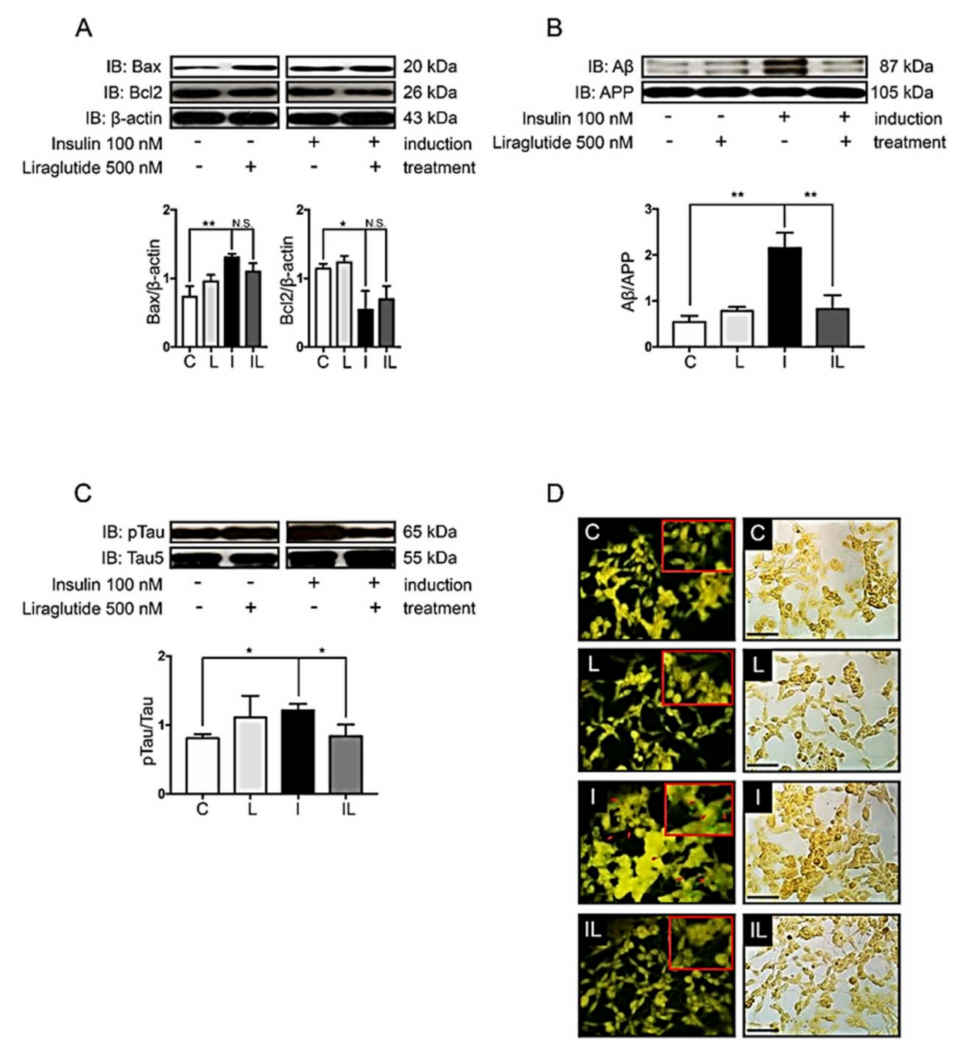
Figure 5. E ff ects of liraglutide on the formation of Alzheimer’s markers, plaque formation, and neuronal apoptosis. The normal cells (C) and insulin-resistant cells (I) insulin-resistant cells without liraglutide (L) or with liraglutide (IL) were used to determine protein expression including apoptotic signal proteins Bax and Bcl-2 ( A ), A β ( B ) and tau protein ( C ). The immunoreactive bands and bar graphs represent densitometric values of each lane after normalizing with total protein actin, amyloid precursor protein (APP), and tau protein, respectively. Values are mean ± SEM * p < 0.05, ** p < 0.01 compared with insulin-resistant cells. Thioflavin-S staining of neuritic plaques was done in SH-SY5Y cells ( D ). The normal cells without liraglutide (C) or with liraglutide (L), together with insulin-resistant cells without liraglutide (L) or with liraglutide (IL) treatment, were visualized by fluorescent microscope at 40 × magnification. Red arrows indicate Thioflavin-S stained neuritic plaques. Scale bar 25 µ m. All experiments shown were from n =